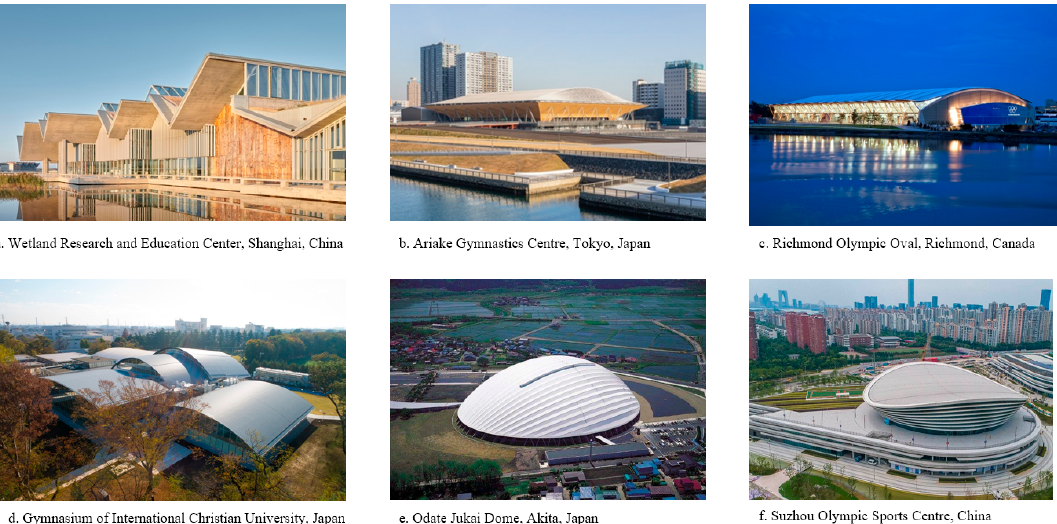
Figure 1. Various shapes of gymnasiums built around the world. ( a ) Wetland Research and Education Center, China [21]; ( b ) Ariake Gymnastics Centre, Japan [22]; ( c ) Richmond Olympic Oval, Canada [23]; ( d ) Gymnasium of the International Christian University, Japan [24]; ( e ) Odate Jukai Dome, Akita, Japan [25]; ( f ) Suzhou Olympic Sports Centre, China [26]. Table 1. Examples of gymnasium building shapes based on the typical plane shape [27]. Basic Plane Shape